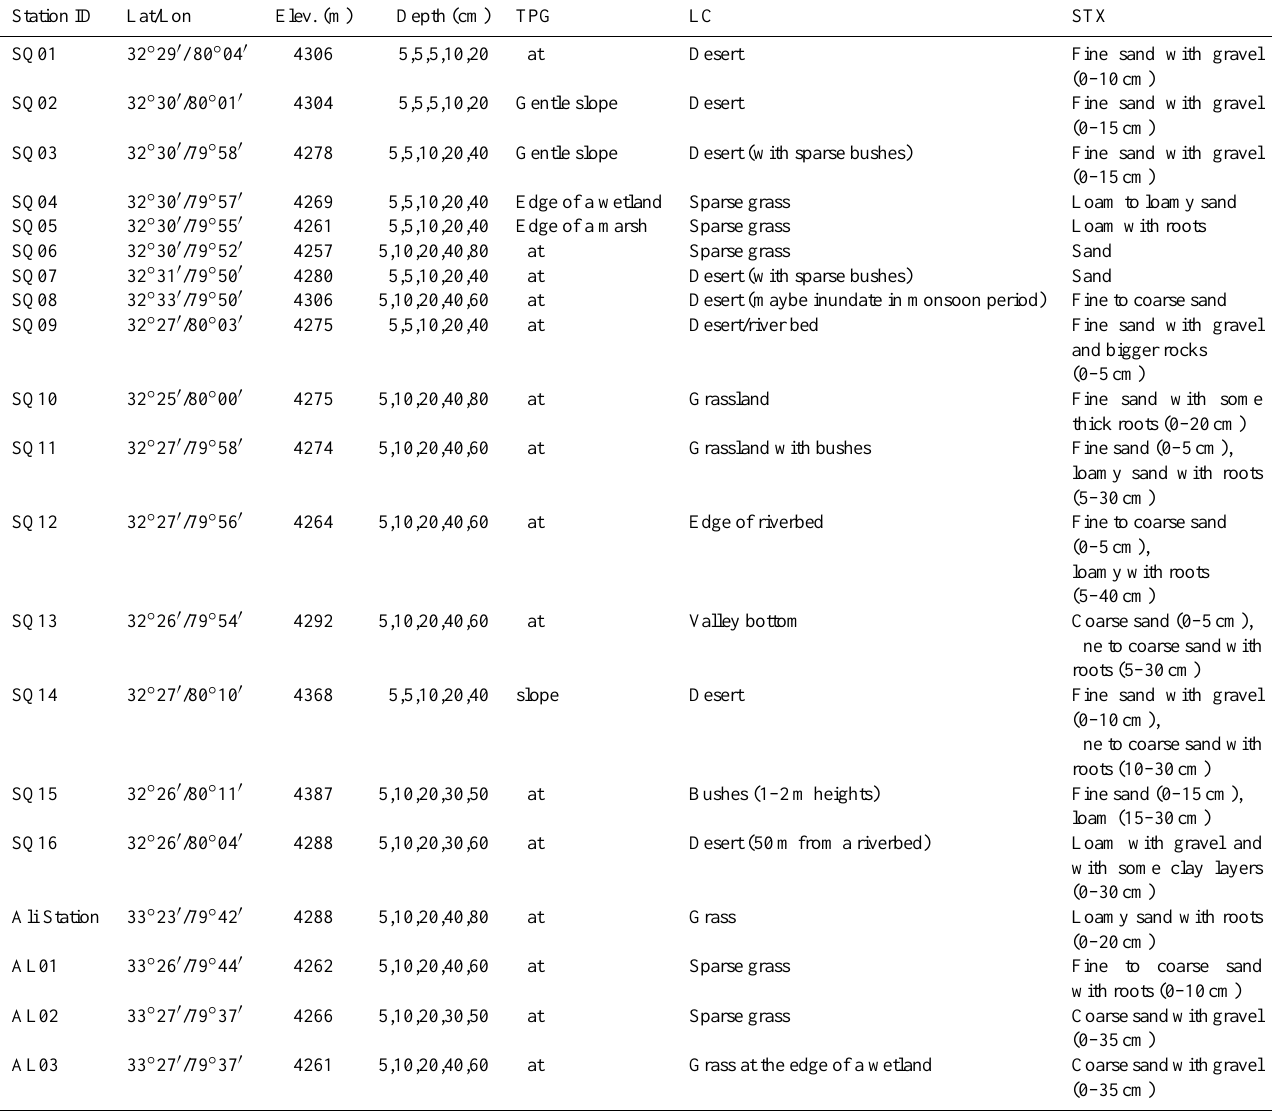
Table 3. Ngari network station information (station name, geographical coordinates, elevation a.s.l., depth of probes, location topography (TPG), land cover (LC), soil texture (STX), Not